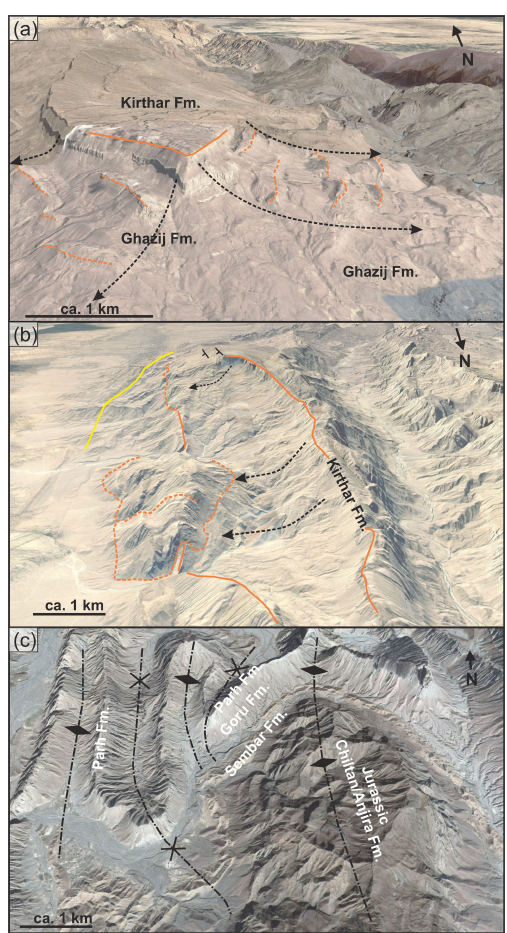
Figure 7. Example for remote fieldwork with Google Earth. Loca- tions of the views are indicated in Fig. 6. (a) Recent mass wasting: blocks of Kirthar limestones glide down the eroded flanks of soft Ghazij Formation; (b) sub-recent to recent mass wasting: a large slab of Kirthar limestones from the anticline roof is slumped over the forelimb of the anticline (see Fig. S1). In the background exten- sional faults are visible in the Kirthar limestones representing the roof of the anticline. The limestones partly glide over the vertical beds of the forelimb. (c) Disharmonic folding: Jurassic rocks show large-wavelength folding, while the hard limestones of the Creta- ceous Parh Formation are folded in smaller wavelength and higher frequency. A weak décollement zone is located in the Goru